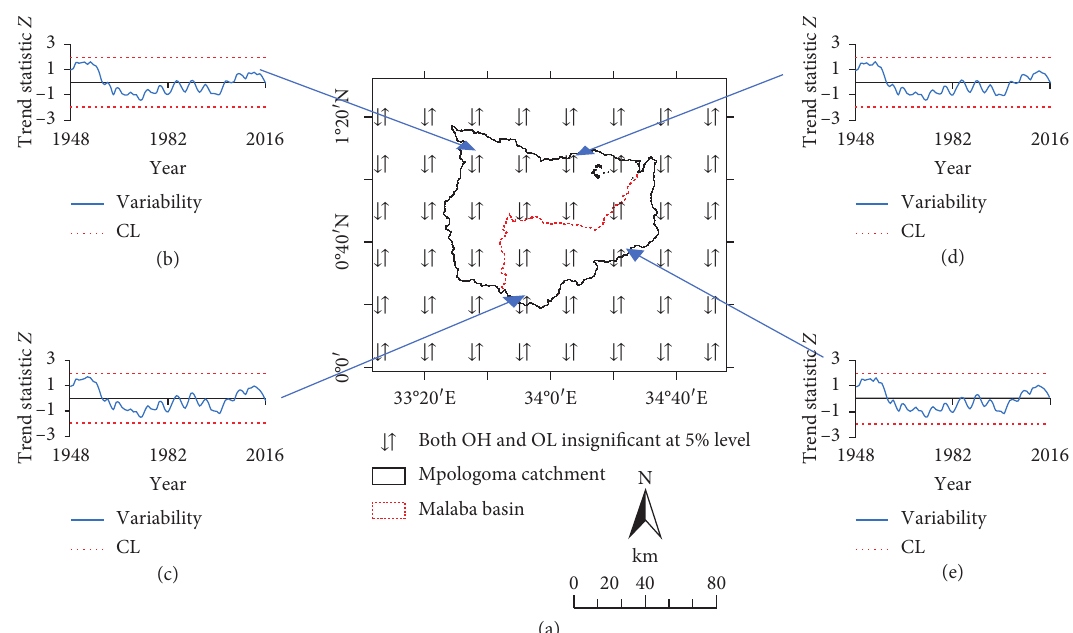
Figure 4: Spatial differences in the significance of rainfall variability (a) and temporal variability in annual and OND rainfall (b–e) at different locations of the study